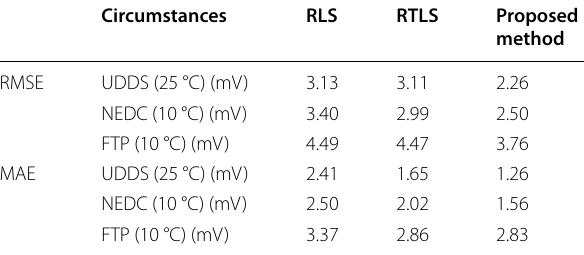
Table 4 MAE and RMSE of modeling